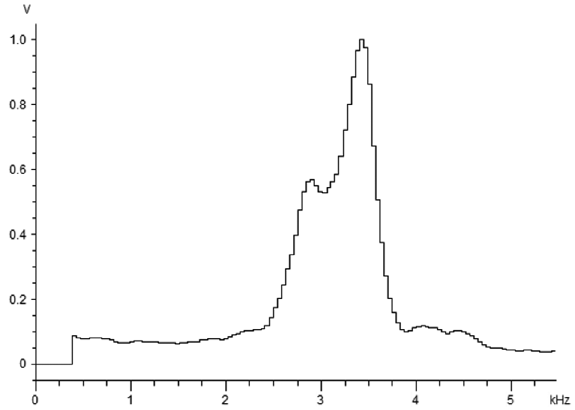
Figure 17. Power spectrum of an advertisement call from Choe- rophryne bisyllaba sp.